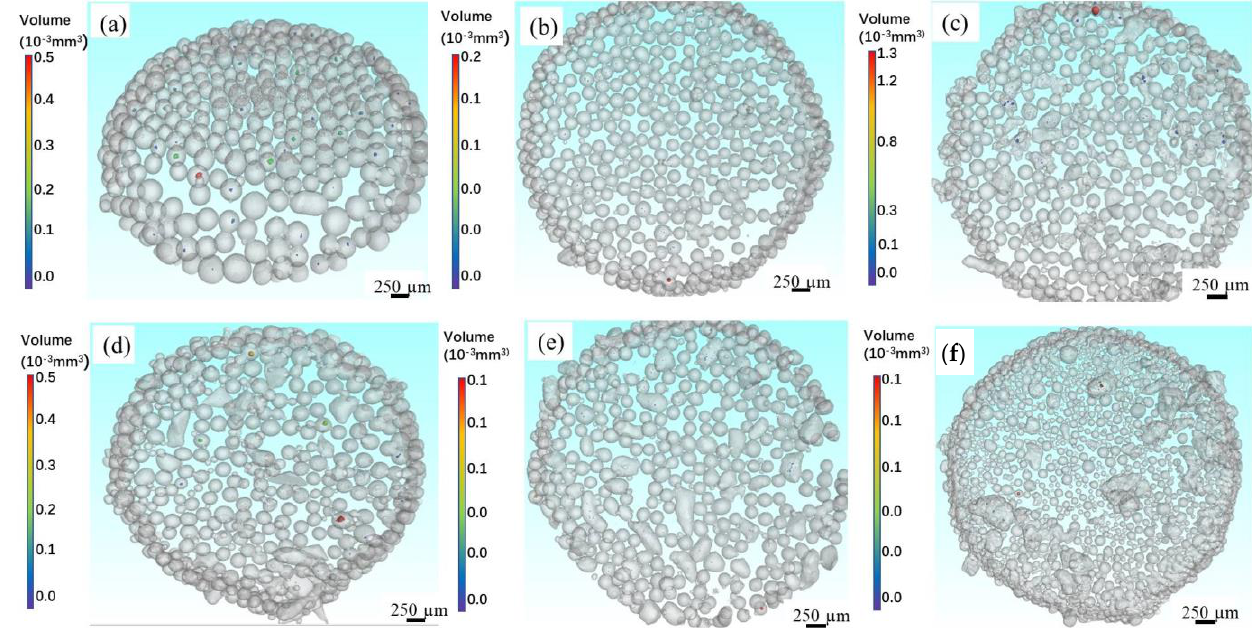
Figure 6. The 3D reconstructed CT of ( a ) Ti-6Al-4V, ( b ) Co-Cr-Mo, ( c ) 316L at 8000 RPM; as well as ( d ) Ti-6Al-4V, ( e ) Co-Cr-Mo, ( f ) 316-steel at 12,000 RPM.